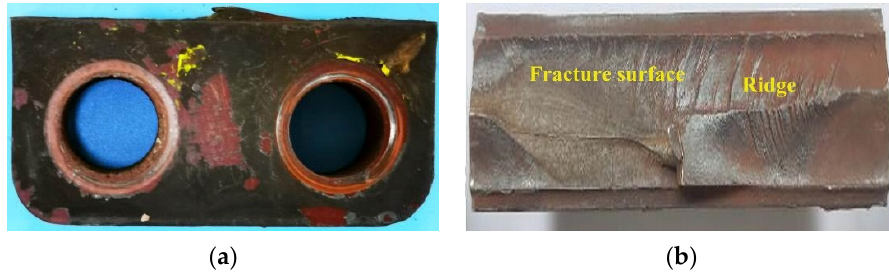
Figure 2. Macro-morphology of the fractured lifting mechanism: ( a ) macro-morphology of the lifting mechanism; ( b ) macro-morphology of the fracture.